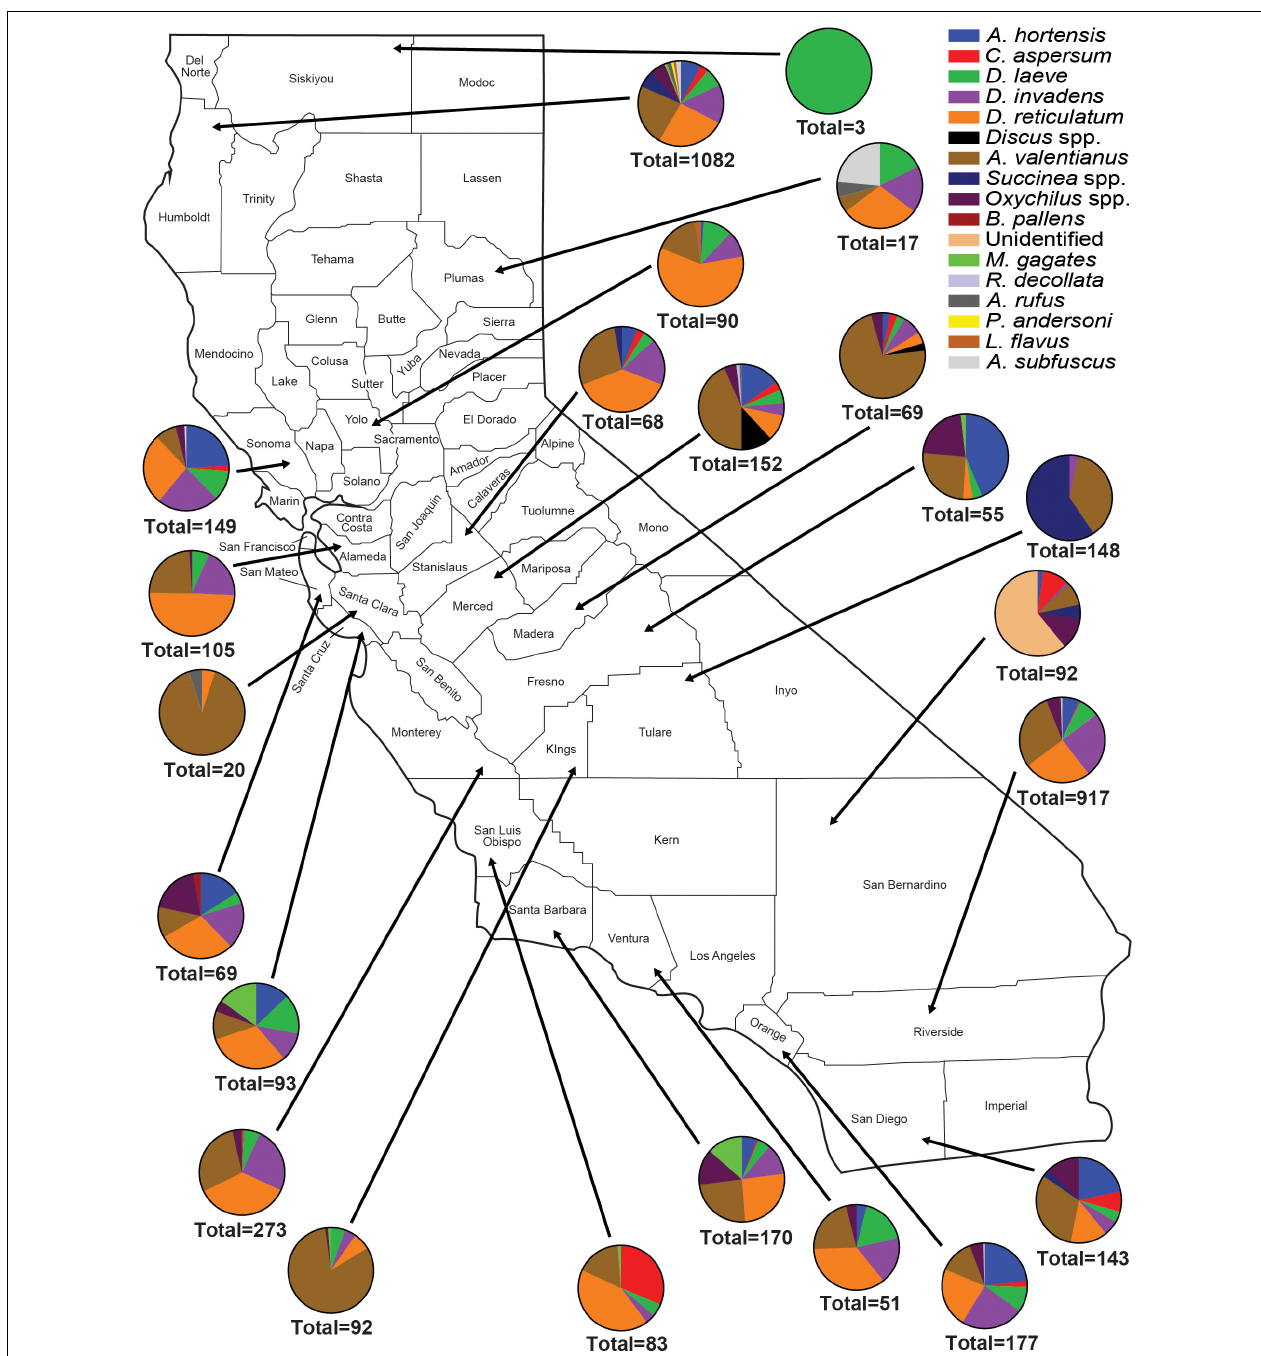
FIGURE 3 | Abundance and species richness of terrestrial gastropods collected in nurseries in each California county surveyed between 2012 and 2017. Surveys were performed during late fall or winter. Survey methods included 1 human hour searching for gastropods throughout each nursery. Collected gastropods were organized by species and were taken back to the laboratory for later verification of species